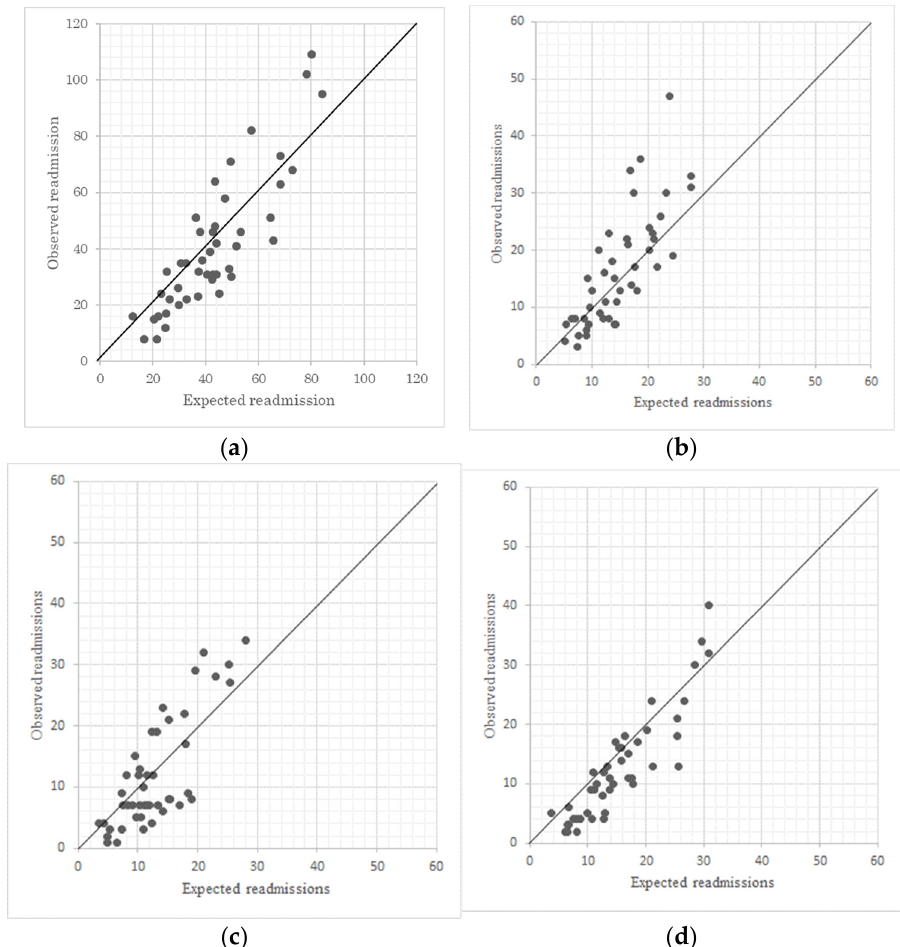
Figure 1. Variation of the HSRRs; ( a ). 9-year model; ( b ) 3-year model (2010–2012); ( c ). 3-year model (2013–2015); ( d ). 3-year model (2016–2018). Table 3. Correlation between the HSRRs in each consecutive period (3-year